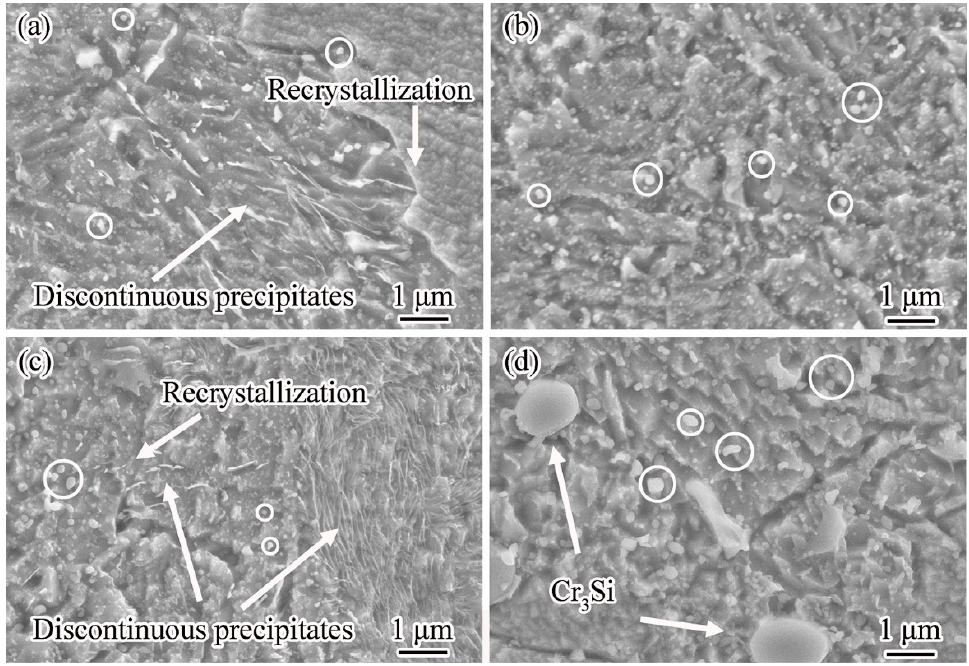
Figure 9. SEM images of CuNiSi and CuNiSiCr alloys aged at 723 K for various time: ( a ) CuNiSi and ( b ) CuNiSiCr for 12 h, ( c ) CuNiSi and ( d ) CuNiSi for 24 h.